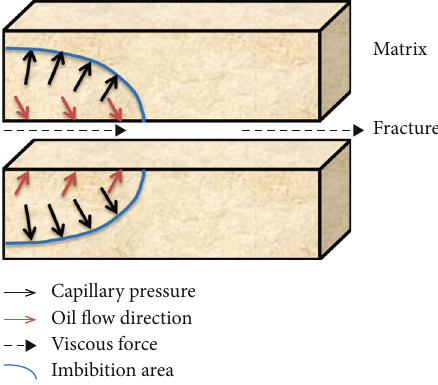
Figure 1: Water imbibition progress between the matrix and